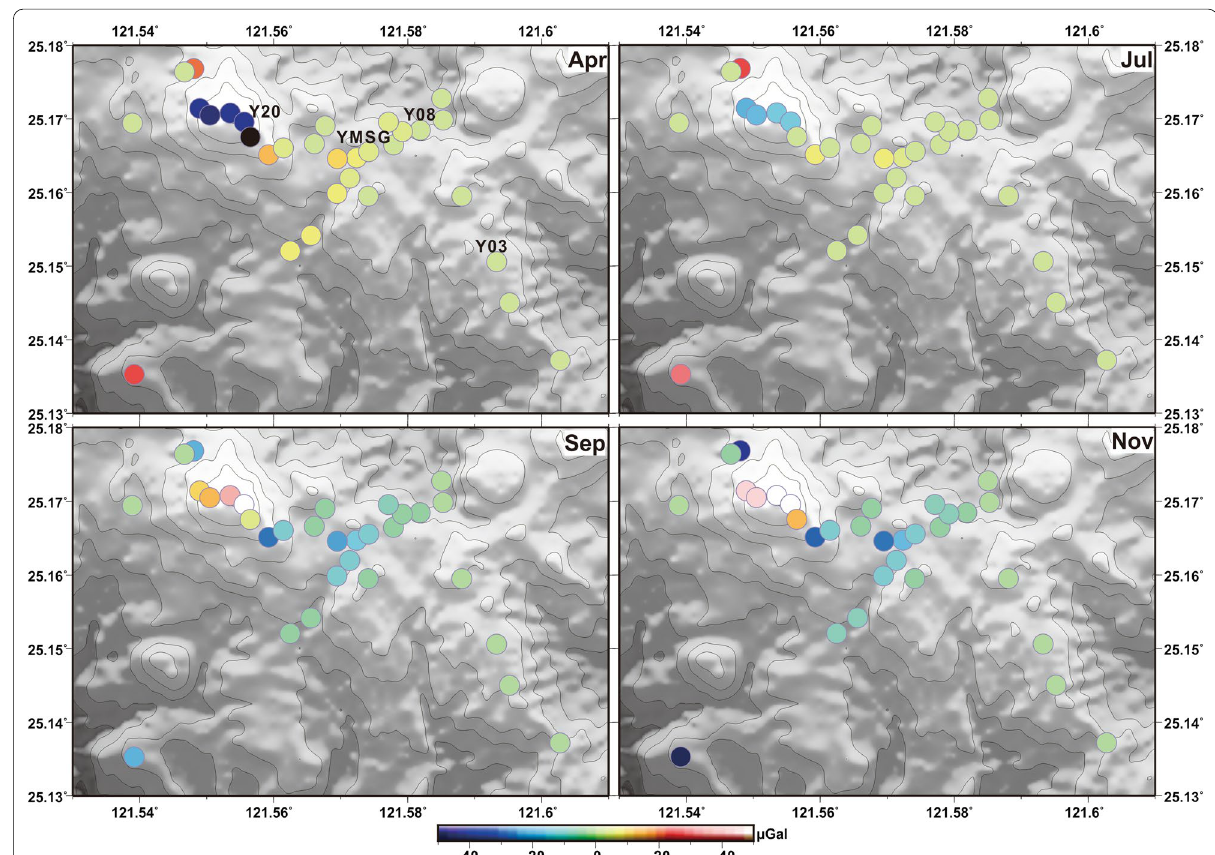
Fig. 7 Simulated gravity changes from the groundwater levels from Model A for the survey periods in April, July, September and November